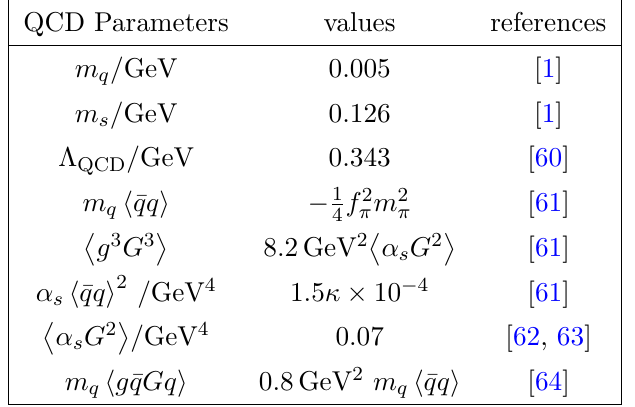
Table 1 . Phenomenological parameters (at the scale (cid:22) 0 = 1